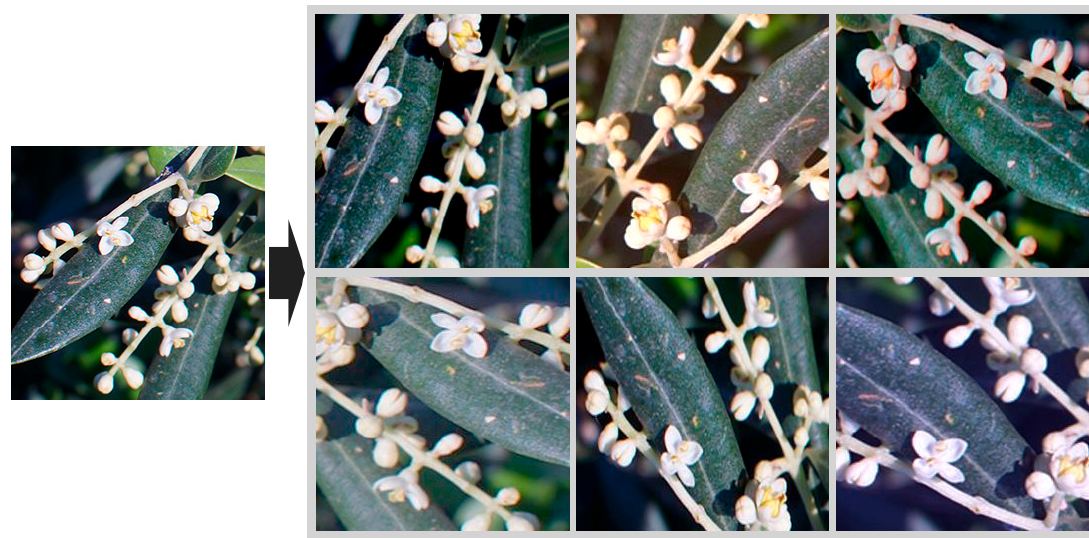
Figure 10. Original test example and six generated augmented images.